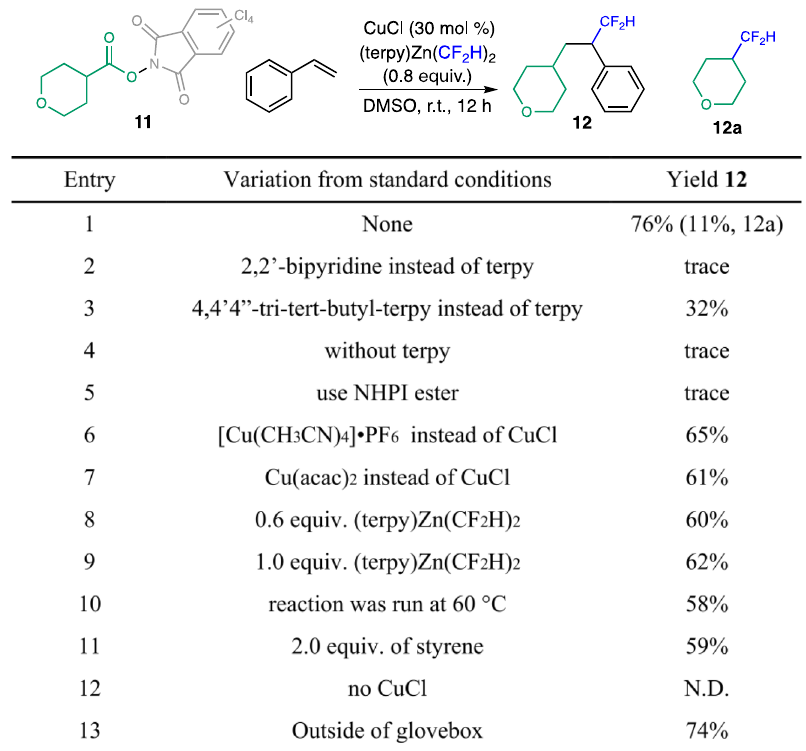
Fig. 3 Optimization of the copper-catalyzed di fl uoromethyl-alkylation of alkenes. Reactions were conducted with 11 (0.1 mmol, 1.0 equiv.), styrene (0.3 mmol, 3.0 equiv.), (terpy)Zn(CF 2 H) 2 (0.08 mmol, 0.8 equiv.) and CuCl (30 mol%) in DMSO (0.4 mL). (terpy)Zn(CF 2 H) 2 was formed in situ by pre-mixing (DMPU) 2 Zn(CF 2 H) 2 and terpy in DMSO. Yields were determined by 19 F NMR using 1- fl uoro-3-nitrobenzene as the internal standard. terpy, 2,2 ʹ ;6 ʹ ,2 ʺ